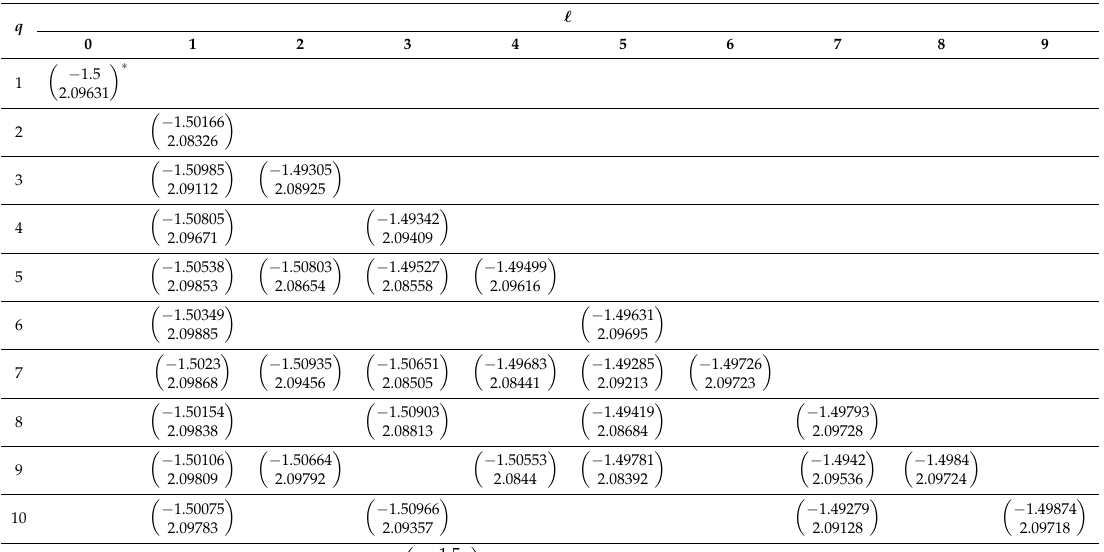
Table 1. Typical (cid:96) / q –bifurcation points λ (cid:96) , q for 1 ≤ q ≤ 10 along γ 1 ( t )